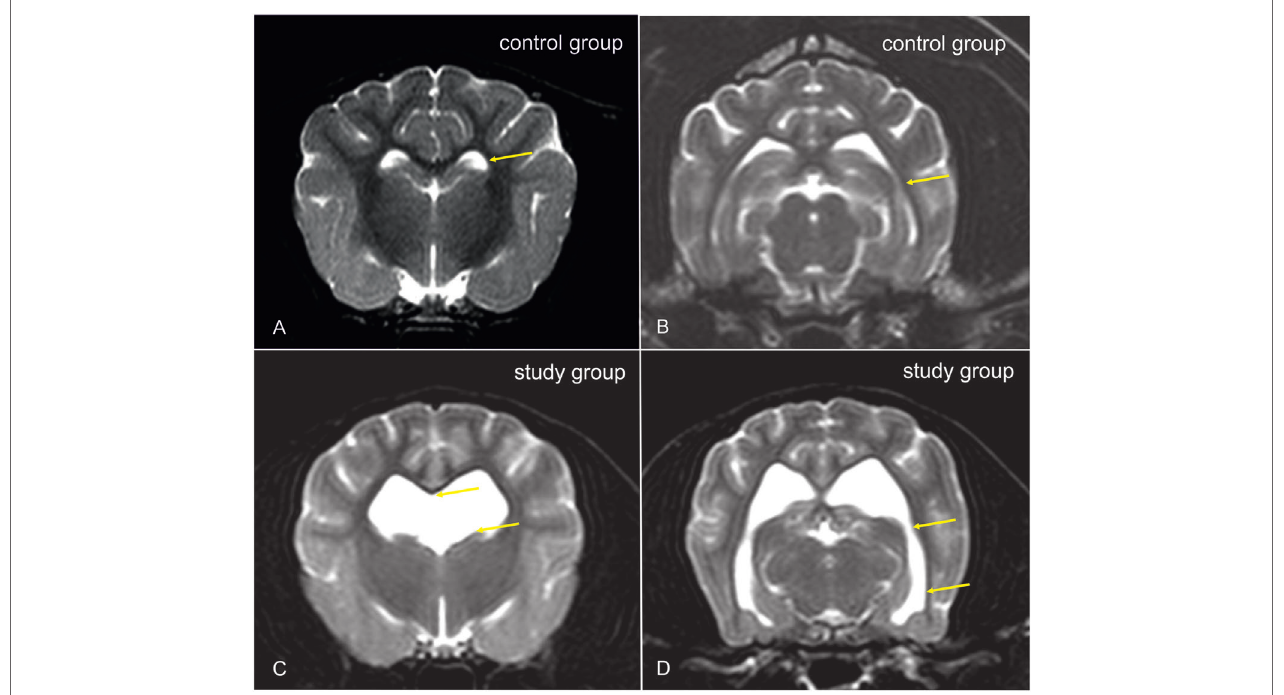
FigUre 1 | Transverse T2-weighted images of the brain of a Cavalier King Charles spaniel (CKCS) with normal lateral cerebral ventricles [control group, (a,B) ] and a CKCS with ventriculomegaly [study group, (c,D) ]. In the study group, a greater proportion of the brain volume is occupied by the lateral ventricles. The closely spaced walls of the temporal horns [ (B,D) : yellow arrows] and/or the olfactory recesses were separated by cerebrospinal fluid (CSF) in these brains, and the lacking of a septum pellucidum created a large connection between the first and second ventricles [ (c) : yellow arrows].